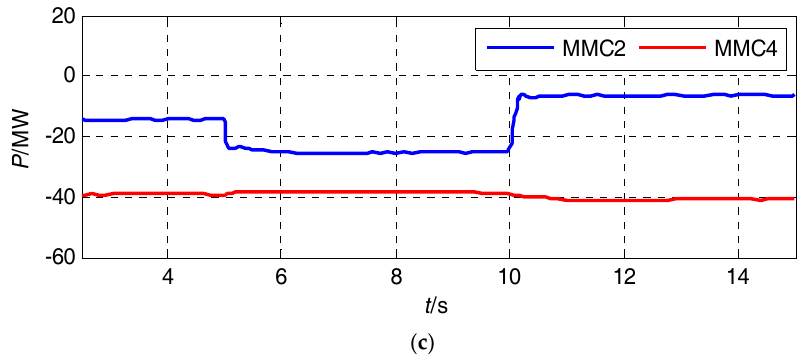
Figure 8. Simulation waveforms of load fluctuation: ( a ) The active power of the receiving end controlled by double closed ‐ loop control (DCLC); ( b ) The active power of receiving end controlled by an MPC method based on a finite control set (FCS ‐ MPC); ( c ) The active power of the receiving end controlled by the hybrid modulated model predictive control (HM 2 PC).